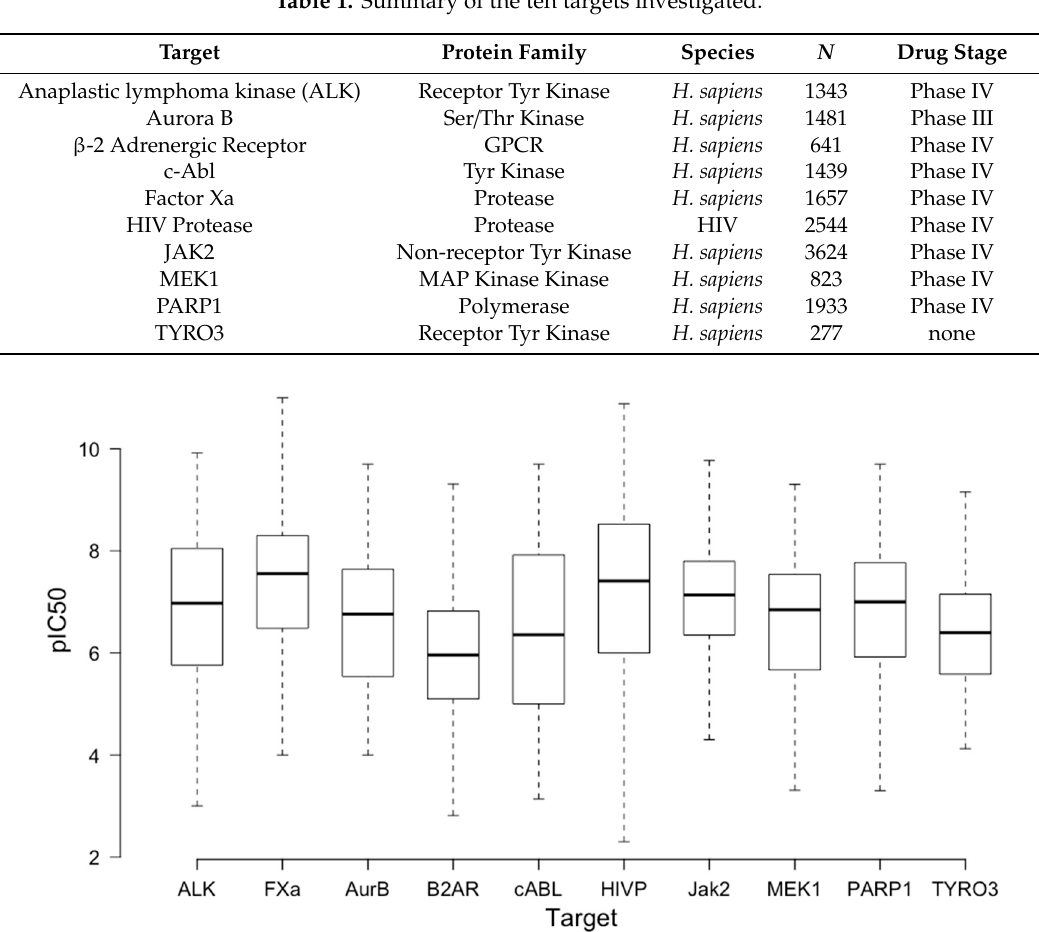
Figure 1. Summary of the activity distribution (pIC 50 ) for the ten targets investigated. (B2AR: β -2 adrenergic receptor and HIVP: HIV protease).